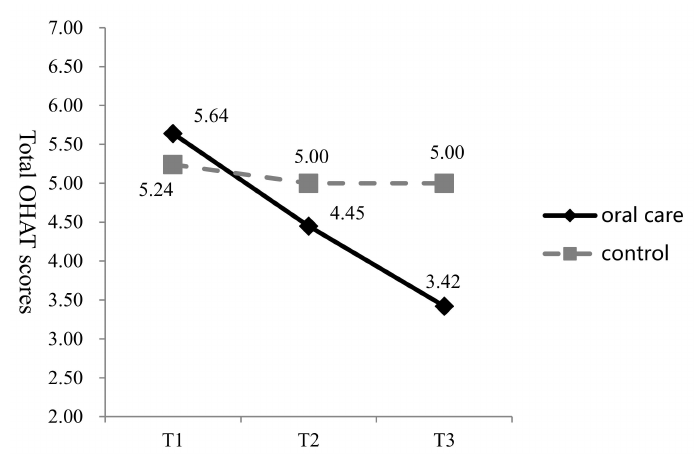
Figure 2. Change in the Oral Health Assessment Tool (OHAT) scores in the two groups at three time points (T1–T3).